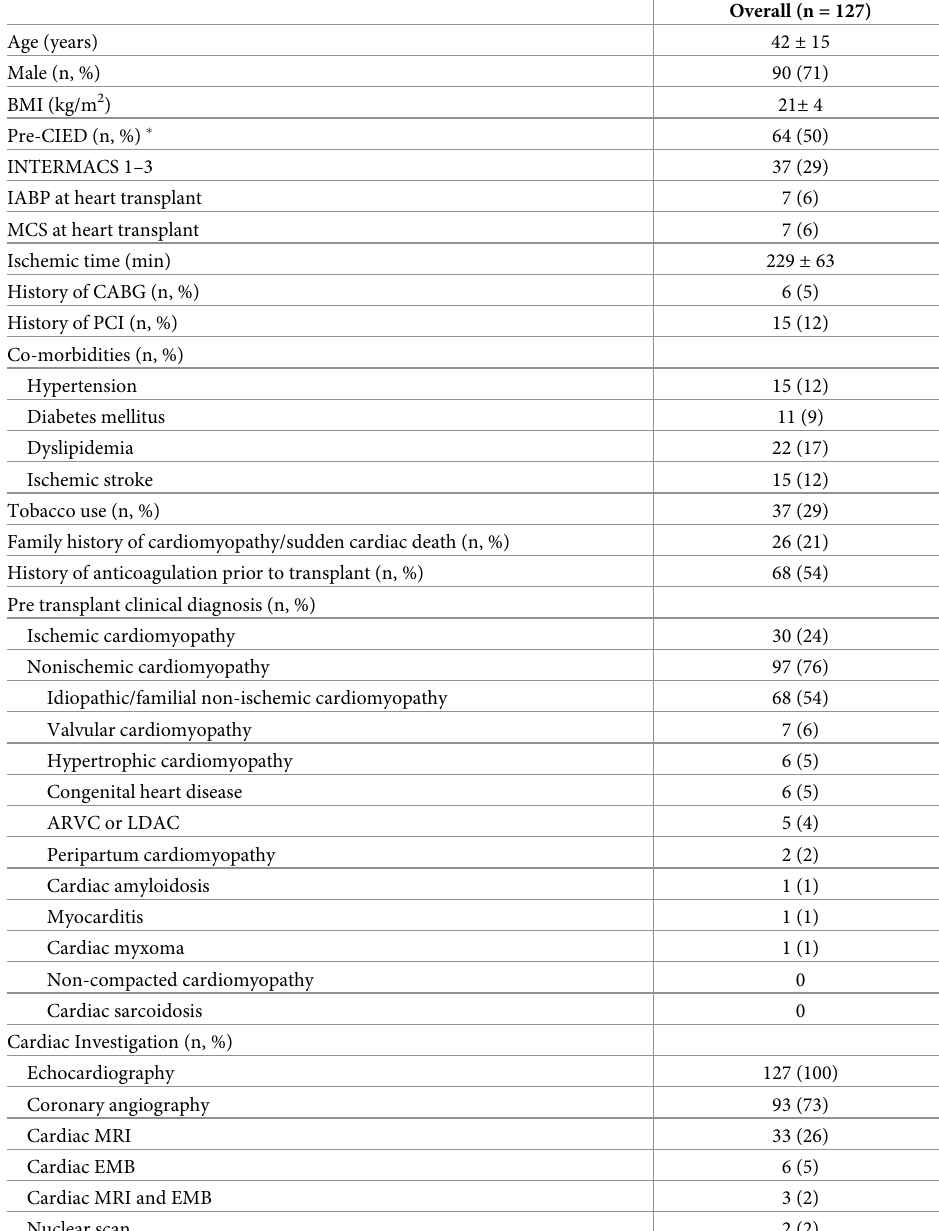
Table 1. Baseline patient